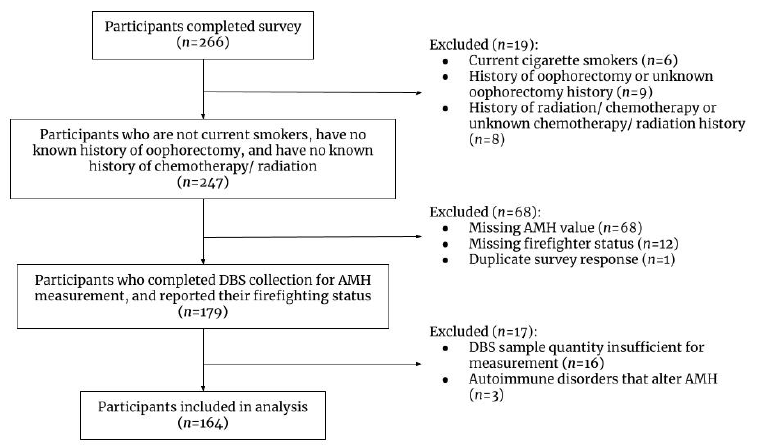
Figure 1. Participant flow diagram. Totals excluded do not sum to sub-categories, as some participants met multiple exclusion